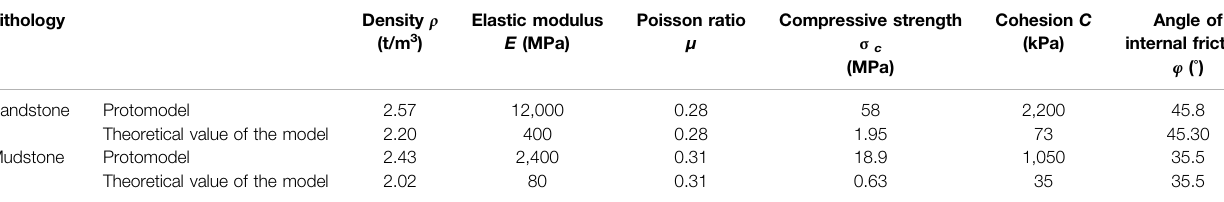
TABLE 2 | Physical and mechanical parameters of blasting physical model and photo model.